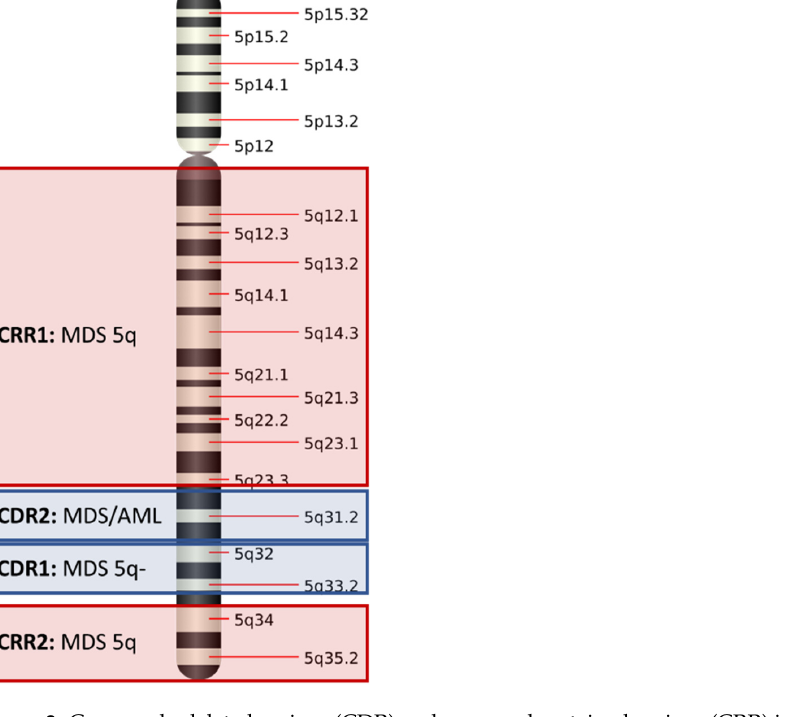
Figure 3. Commonly deleted regions (CDR) and commonly retained regions (CRR) in chromosome 5q.